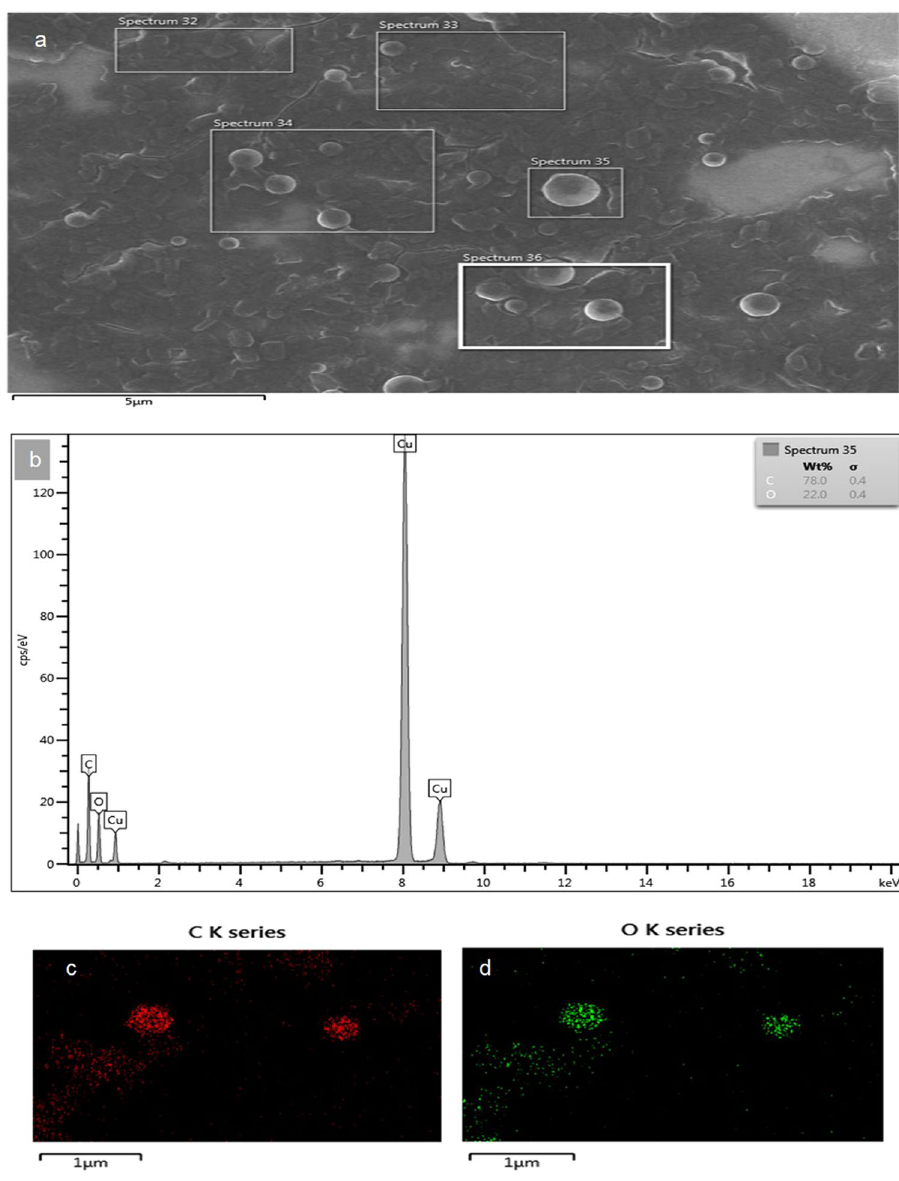
Figure 3. Elemental analysis by energy-dispersive X-ray spectroscopy (SEM/EDS): ( a ) EDS X-ray mapping showing electron images of spherical 4A particles. ( b ) EDS spectrum showing the percentage elemental compositions in 4A particle (Spectrum 35). The primary peaks suggest a typical hydrocarbon by the ratio of carbon and oxygen. Usually, hydrogen cannot be observed by X-ray spectroscopy; ( c , d ) showing respective EDS/electron distribution of carbon and oxygen on the surface of 4A particle. Here the colors of red ( C K series) and green ( O K series) represent carbon and oxygen